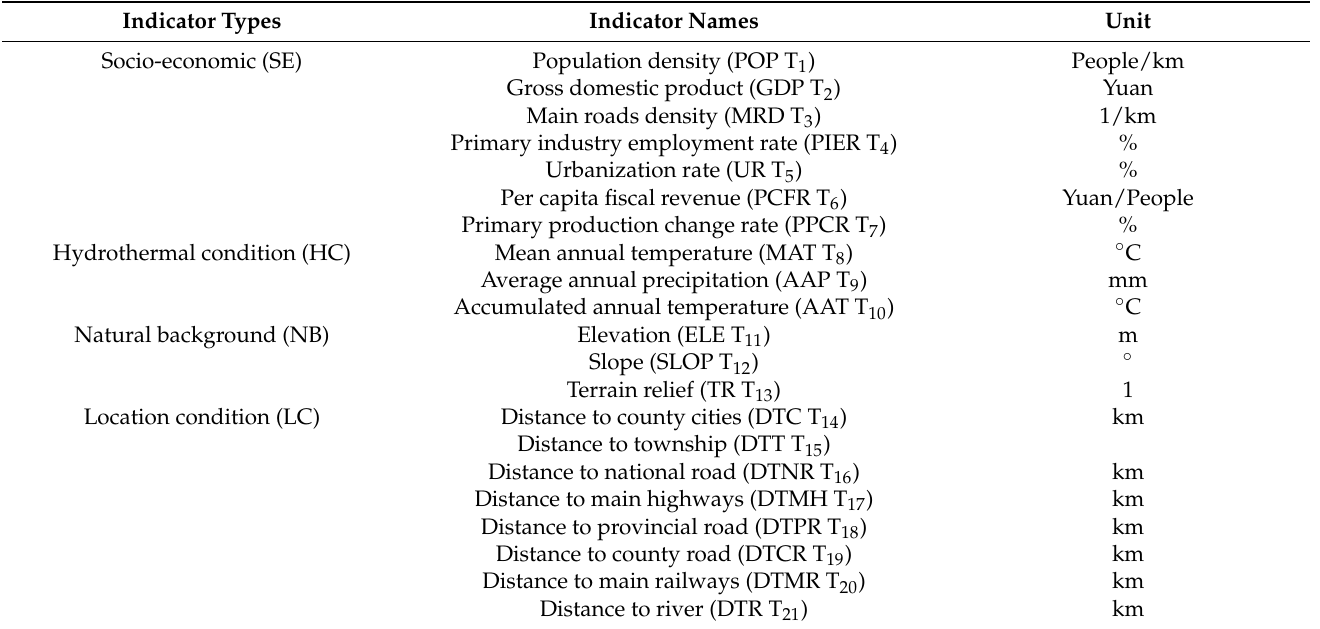
Table 2. The driving index of